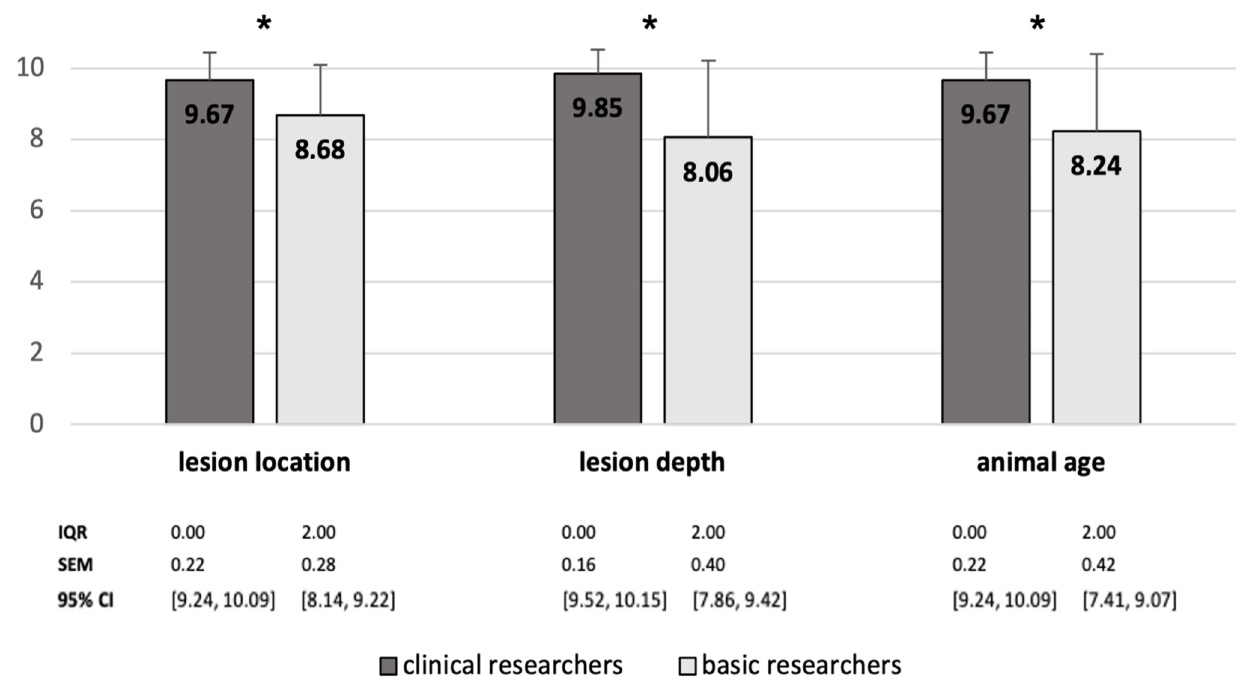
Figure 4. Survey aspects with statistically significant different ratings by clinical working researchers and basic researchers. Whiskers represent standard deviations. Significant differences (* p < 0.05) are designated with asterisks. IQR interquartile range; SEM standard error of the mean; CI confidence interval.